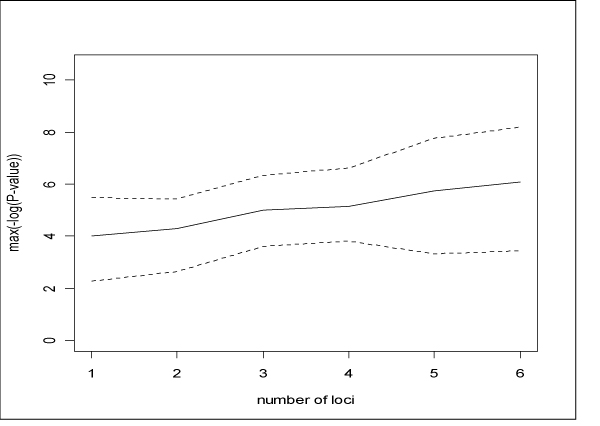
Maximum (across region within replicate) of -log10-transformed p-values. Solid line: Mean value (over replicates). Upper and lower dotted lines: 80th percentile and 20th percentile of the maximum -log10-tranformed p-values, respectively.